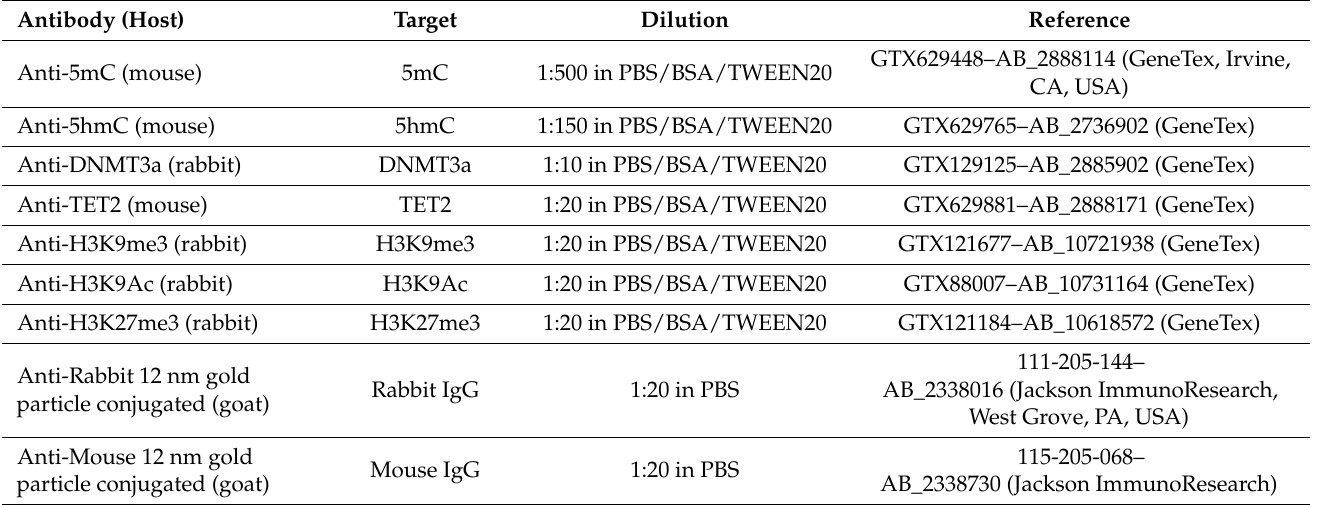
Table 1. List of antibodies used for EM immunolabelling. Antibodies name, host, target, dilution, and code are reported.